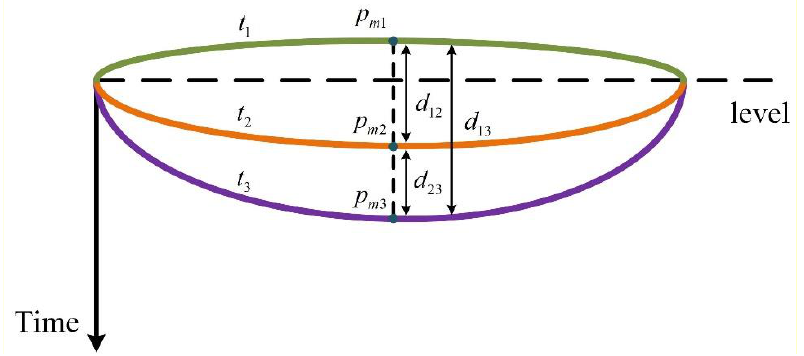
Figure 12. Solving for subsidence (uplift).